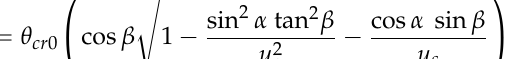
load sediment particle moving on a slope bed. The slope angle is β , and the angle between the flow direction and the downslope direction is α . Assuming the particle is not moving, the direction of the Shields parameter is the same as the flow direction. According to the force balance, the critical Shields parameter for the sand to move is [36]: